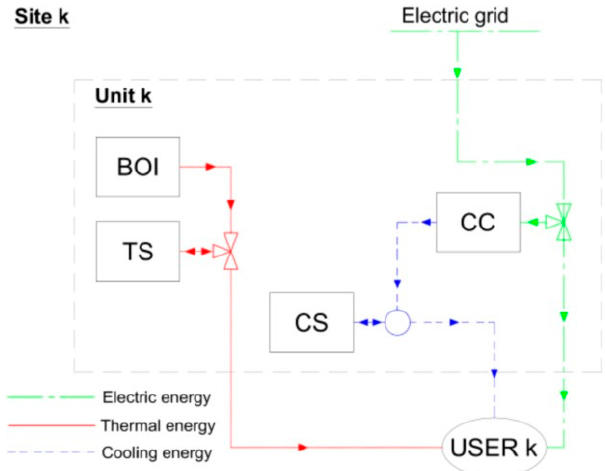
Figure 5. Superstructure of the conventional solution. Table 3. Optimal configuration of the conventional solution.